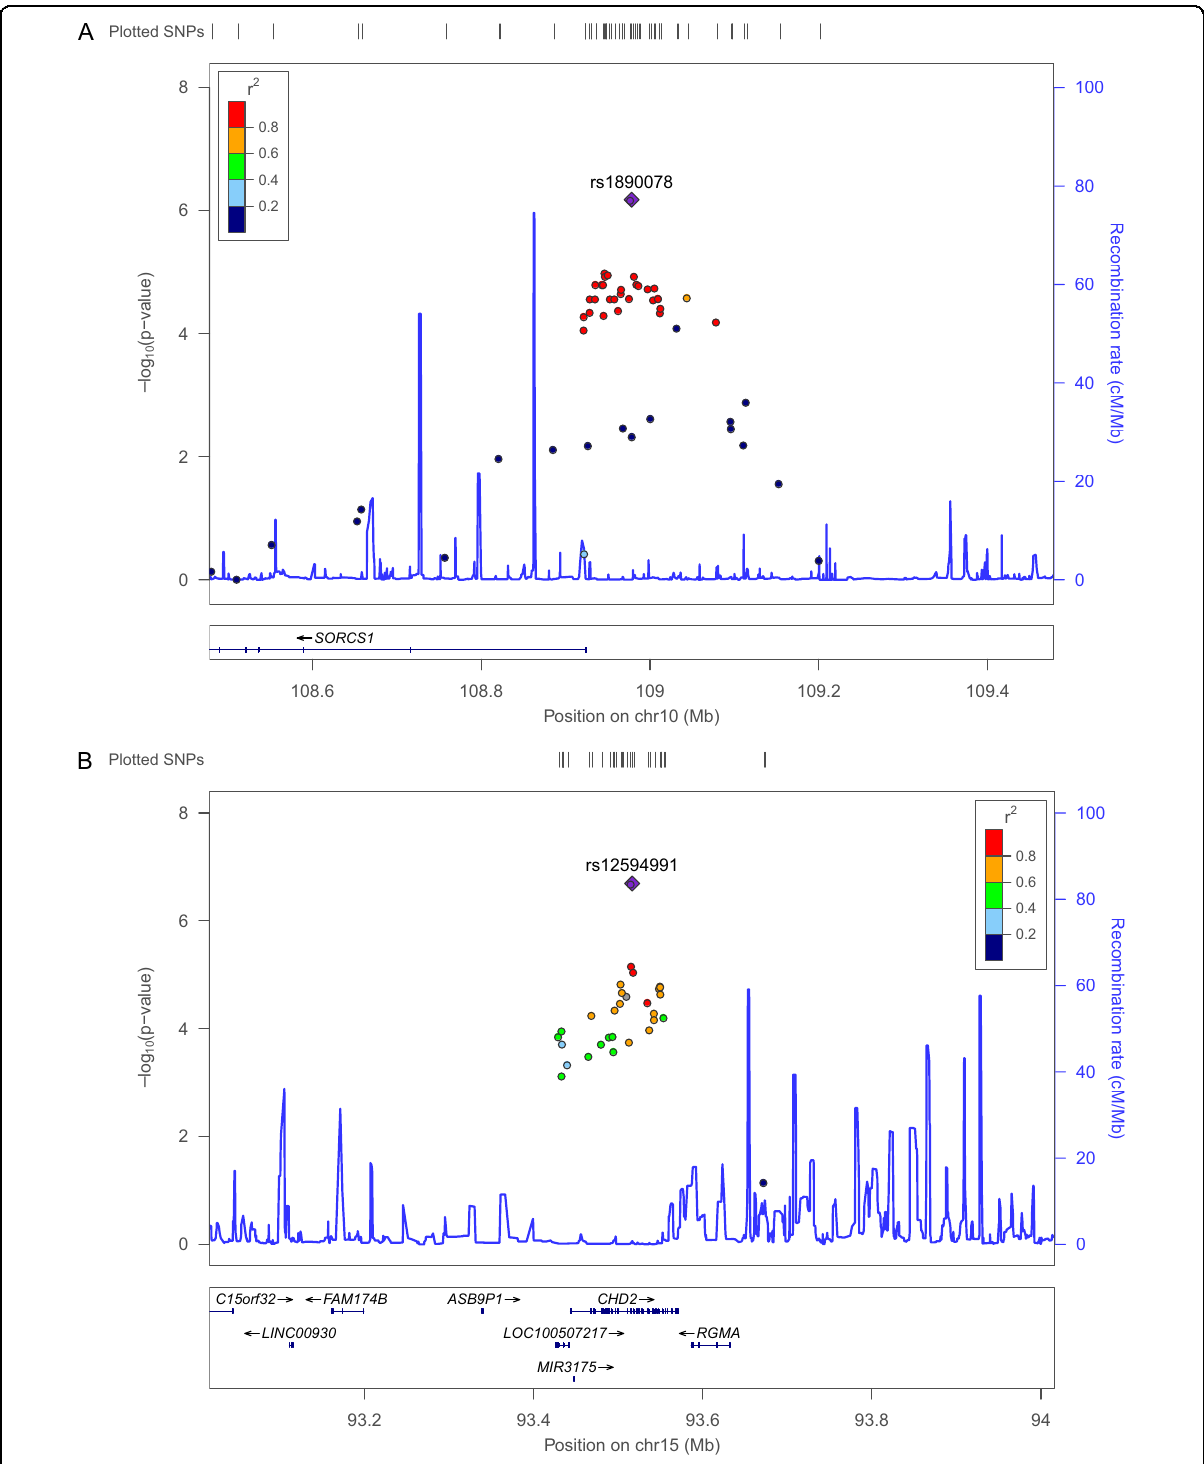
Fig. 3 Regional plot of novel candidate variants signi fi cantly associated within APOE ε 4 carriers. The fi gures show the regional association plot of known representative loci, (A ) 10q25.1; SORCS1 and ( B ) 15q26.1; CHD2 , in the cAD chip application set with a combined P value < 0.000001. The purple shaded diamond shape represents rs1890078 and rs12594991, which are the most signi fi cant SNPs in 10q25.1 ( A ) and 15q26.1 ( B ), respectively. The blue line indicates the recombination rate, while fi lled color represents the linkage disequilibrium score based on r 2 values estimated from the 1000 genome Nov 2014 ASN